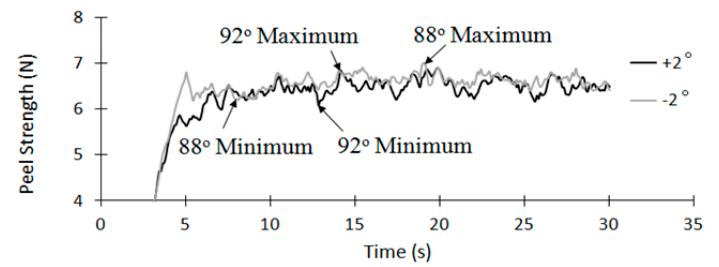
Figure 7. N1 and N2 plot for noise factor.